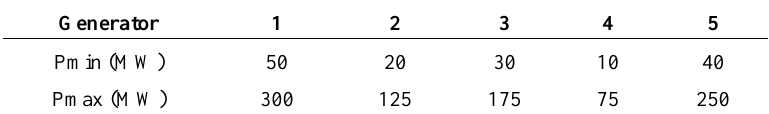
Table 6. Generator active power limits.